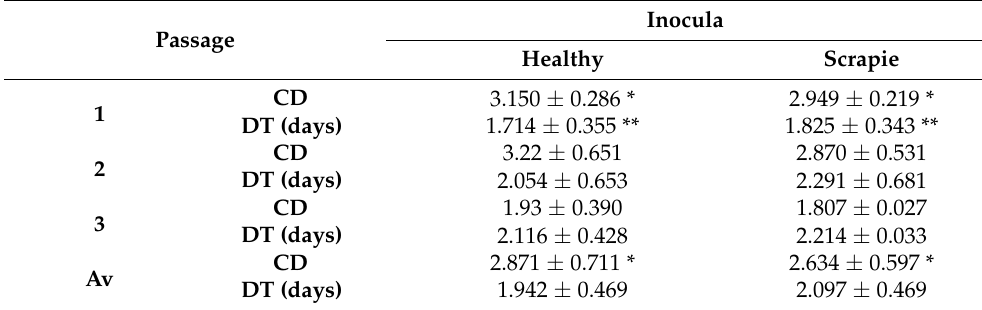
Table 2. Cell doubling number (CD) and cell doubling time (DT) of oBM-MSCs from 3 donors through passages 1 to 3 post-inoculation with 1% brain homogenates obtained from healthy and scrapie sheep and the average value for the three passages (Av). Inocula Passage Healthy Scrapie CD 1 DT